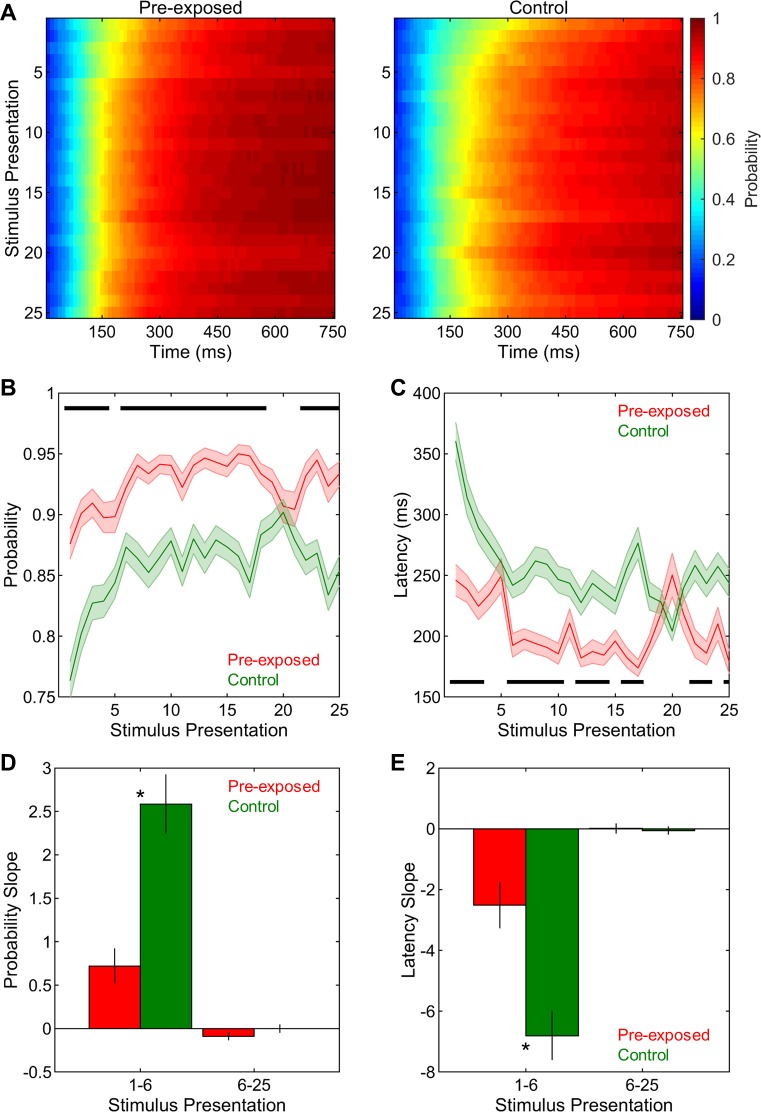
Neural decoding in pre-exposed and control conditions.(A) Neural decoding accuracies were analyzed across time points along the stimulus duration and stimulus presentations in pre-exposed and control conditions. (B) Correct neural decoding probabilities across stimulus presentations were higher in the pre-exposed than in the control condition. (C) The slopes of correct neural decoding probabilities were lower in the pre-exposed than in the control conditions for presentations 1–6. (D) Correct neural decoding latencies across stimulus presentations were shorter in the pre-exposed than in the control condition. (E) The slopes of correct neural decoding latencies were less negative in the pre-exposed than in the control conditions for presentations 1–6. Shadings and error bars indicate SEMs. Horizontal black bars and asterisks denote significant differences.